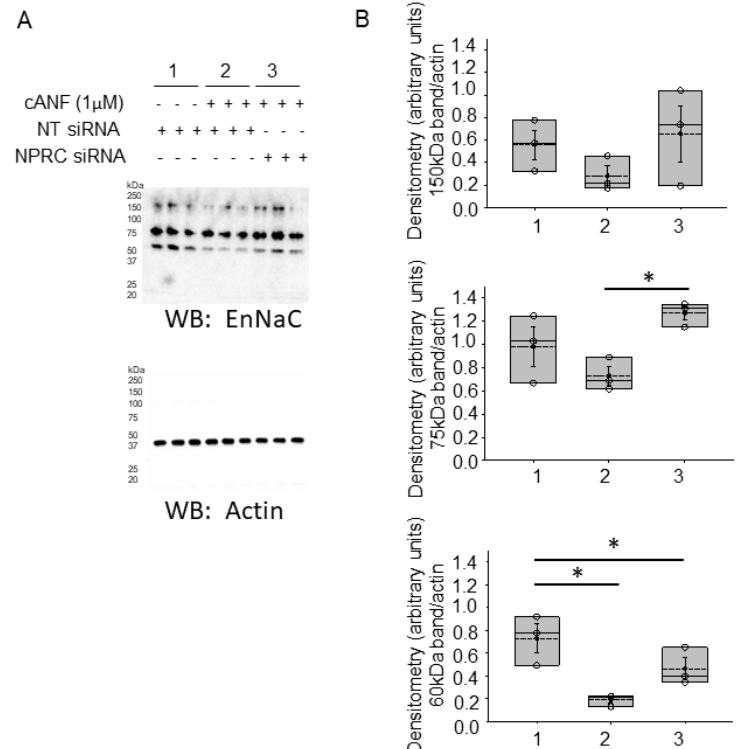
Figure 3. EnNaC alpha subunit protein expression in hAoEC transfected with NPRC specific siRNA compared to cells transfected with non-targeting siRNA. hAoECs were treated with cANF for 3 h. ( A ). Western blot for EnNaC alpha protein after hAoECs were transfected with NPRC specific siRNA or non-targeting (NT) siRNA and then treated with or without cANF before harvesting the cells for protein. ( B ). Densitometric analysis of the 150 kDa, 75 kDa, and 60 kDa immunoreactive bands in ( A ). Each group includes hAoEC cell lysates from three separate siRNA experiments that were loaded on the same gel and probed with EnNaC alpha antibody. A one-way ANOVA was used for statistical analysis of the experimental groups with a Holm–Sidak post hoc test. n = 3 samples for each of the three groups. * represents a p -value < 0.05.